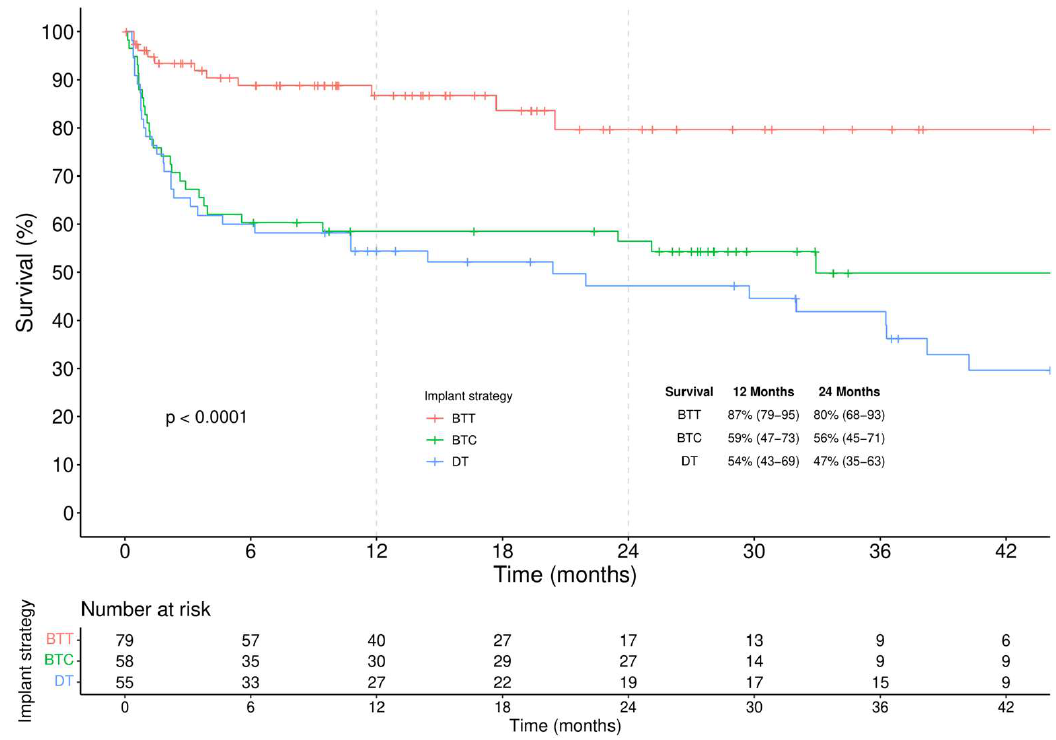
Figure 3. Kaplan-Meier analysis of survival stratified by different implantation strategies.